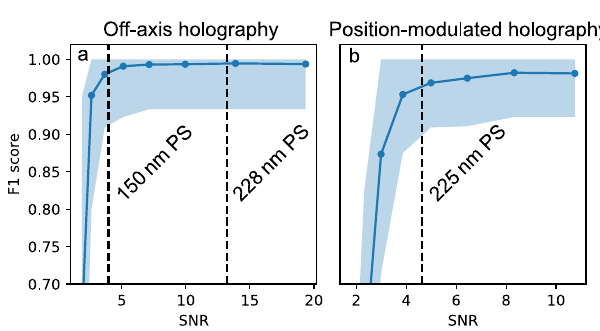
Fig. 5 | Detection accuracy of LodeSTAR on holographic data. The detection F1scoreasafunctionofthesignal-to-noiseratio(calculatedasmax ð ∣ I ∣ Þ = where I isthe fi eld,and σ Re , σ Im arethestandarddeviationsoftherealandimaginary parts of the fi eld), on synthetic data. a F1 score (shaded region is the 0.95-th quantile)ofLodeSTARonthestandardholographicsetup.Forthetwoparticlesizes used,the F1 scoreis around 0.98. b F1 score(shadedregion isthe 0.95-thquantile) ofLodeSTARonthesample-position-modulatedholographicsetup.Fortheparticle size used, the F1 score is around